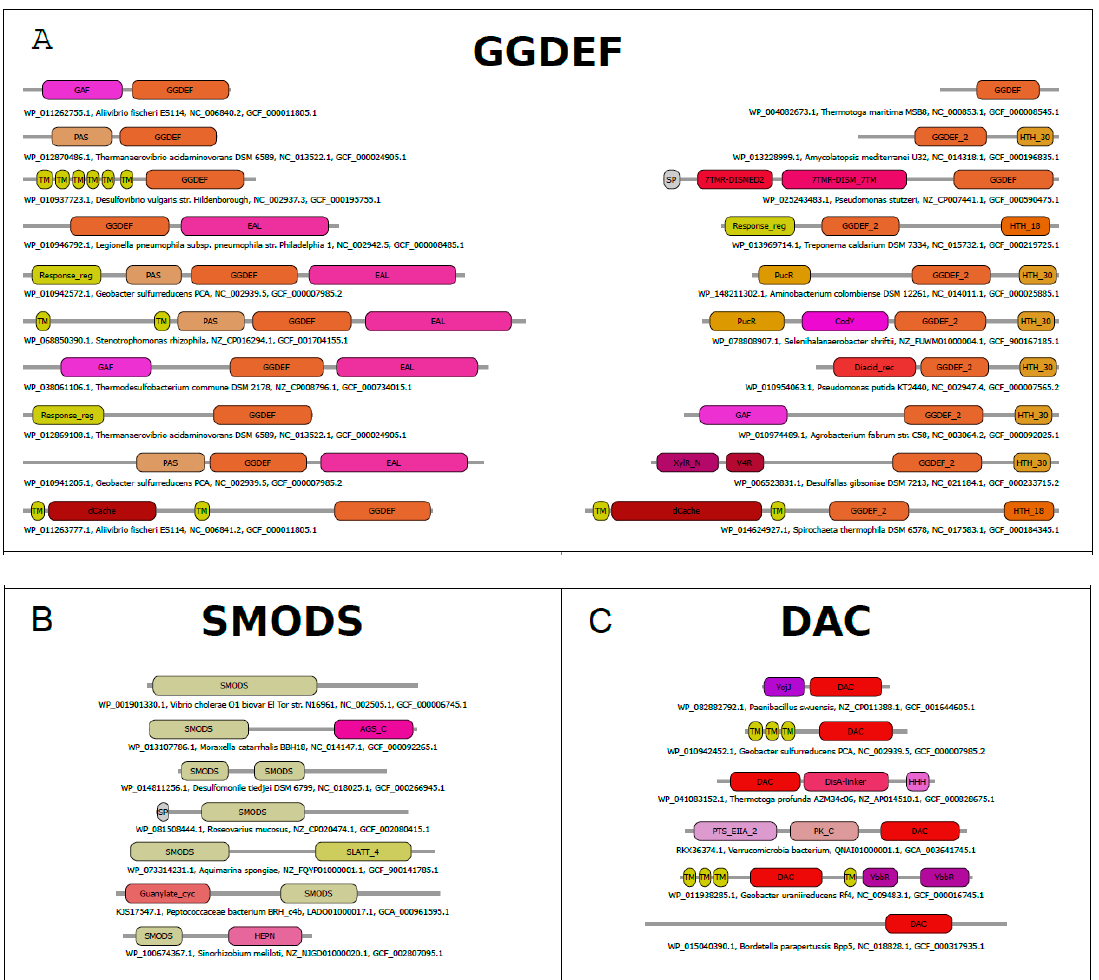
Figure 2. Domain architectures of proteins containing GGDEF, SMODS (Second Messenger Oligonucleotide or Dinucleotide Synthetase), and DAC (di-adenylyl cyclase) domains. The most frequent domain architectures of proteins containing GGDEF ( A ), SMODS ( B ) and DAC ( C ) domains. The analysis was done using a non-redundant dataset ( < 80% identity) of protein sequences built from sequences retrieved from the NCBI protein database [88]. The names of the domains are based on the Pfam database [89] .